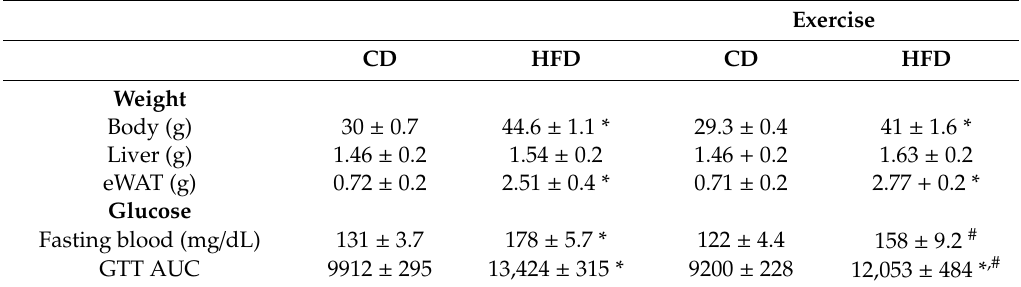
Table 1. Effects of moderate aerobic training in body weight and glucose tolerance in control- and high-fat diet-fed mice.